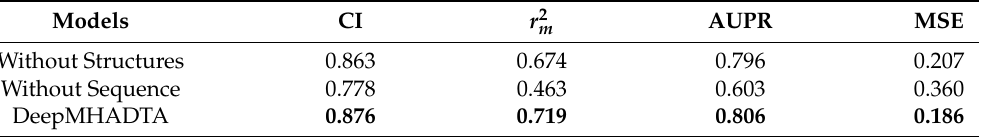
Table 5. Performance of DeepMHADTA with the Ablation model using structures or sequence alone on KIBA dataset.